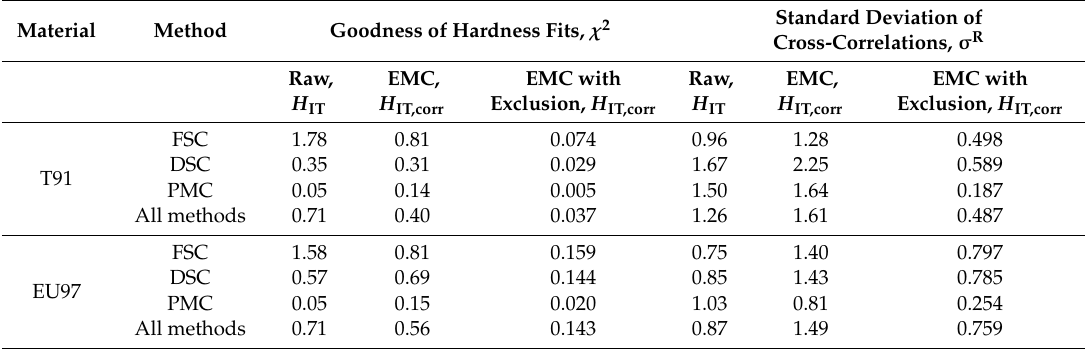
Table 2. Standard error of the exponential fit regressions to raw hardness data and EMC corrected hardness, χ 2 , and standard deviation of cross-correlations between hardness and elastic modulus, σ R , for T91 and Eurofer97 obtained from indentations using di ff erent control measurement